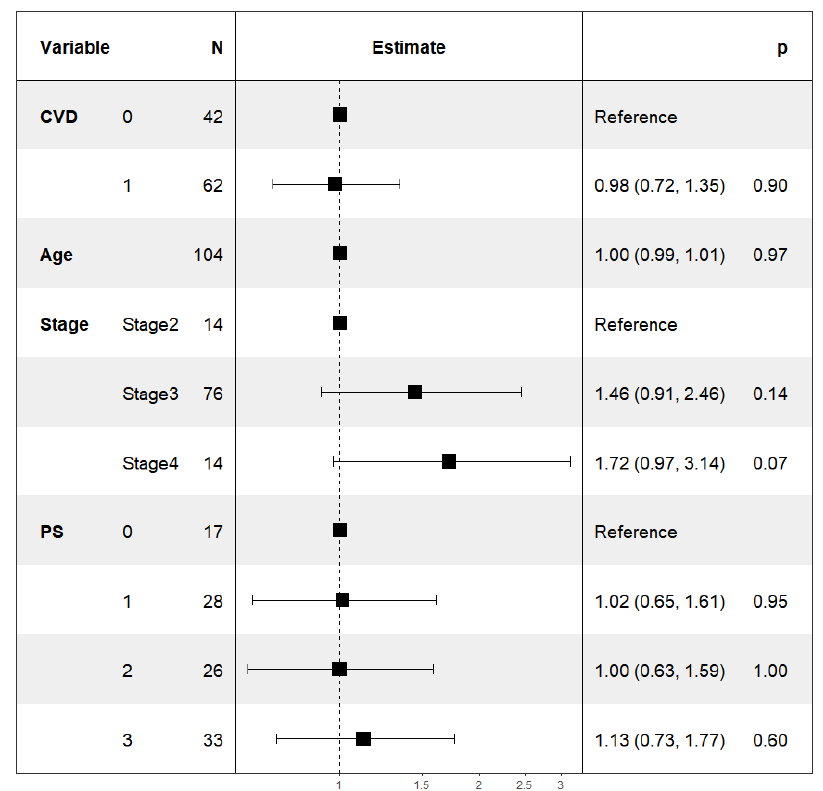
Figure 5. Poisson multivariate regression analysis assessing the impact of various factors on the success of surgical treatment, measured by the residual tumor size.